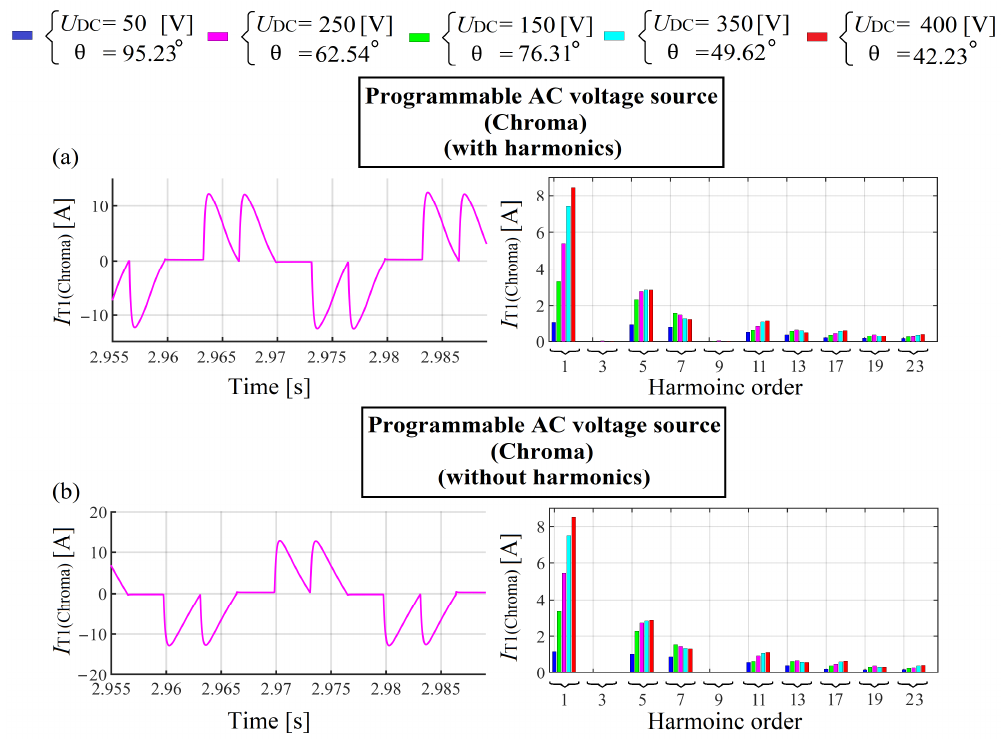
Figure 34. Current waveforms and spectrums measured at the filter terminals when the program- mable voltage source was with: ( a ) harmonics and ( b ) without harmonics. The line reactor L SS is considered.